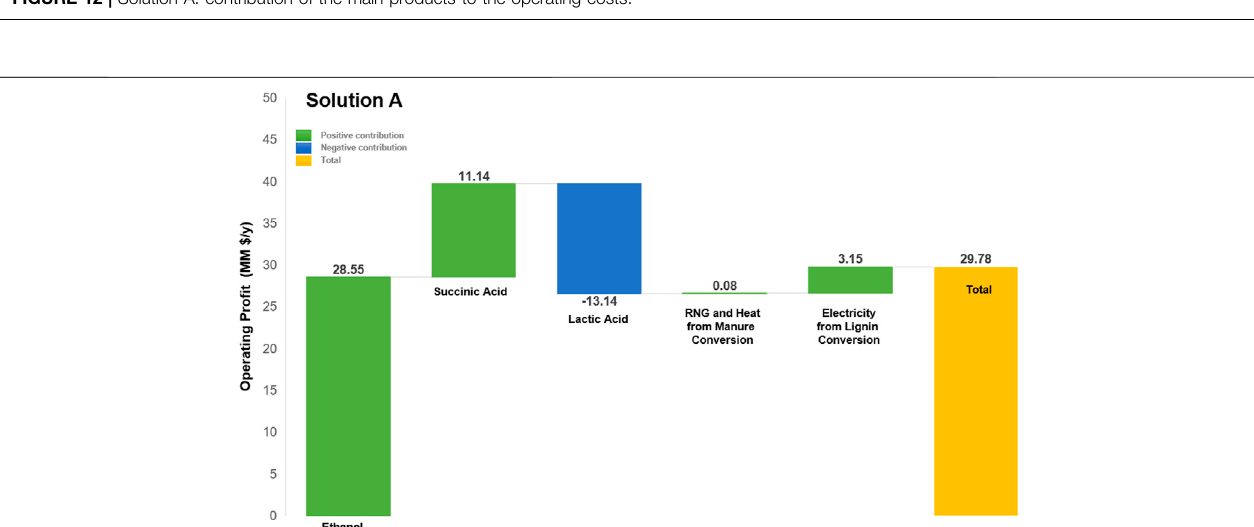
FIGURE 13 | Solution A: contribution of the main products to the operating costs.